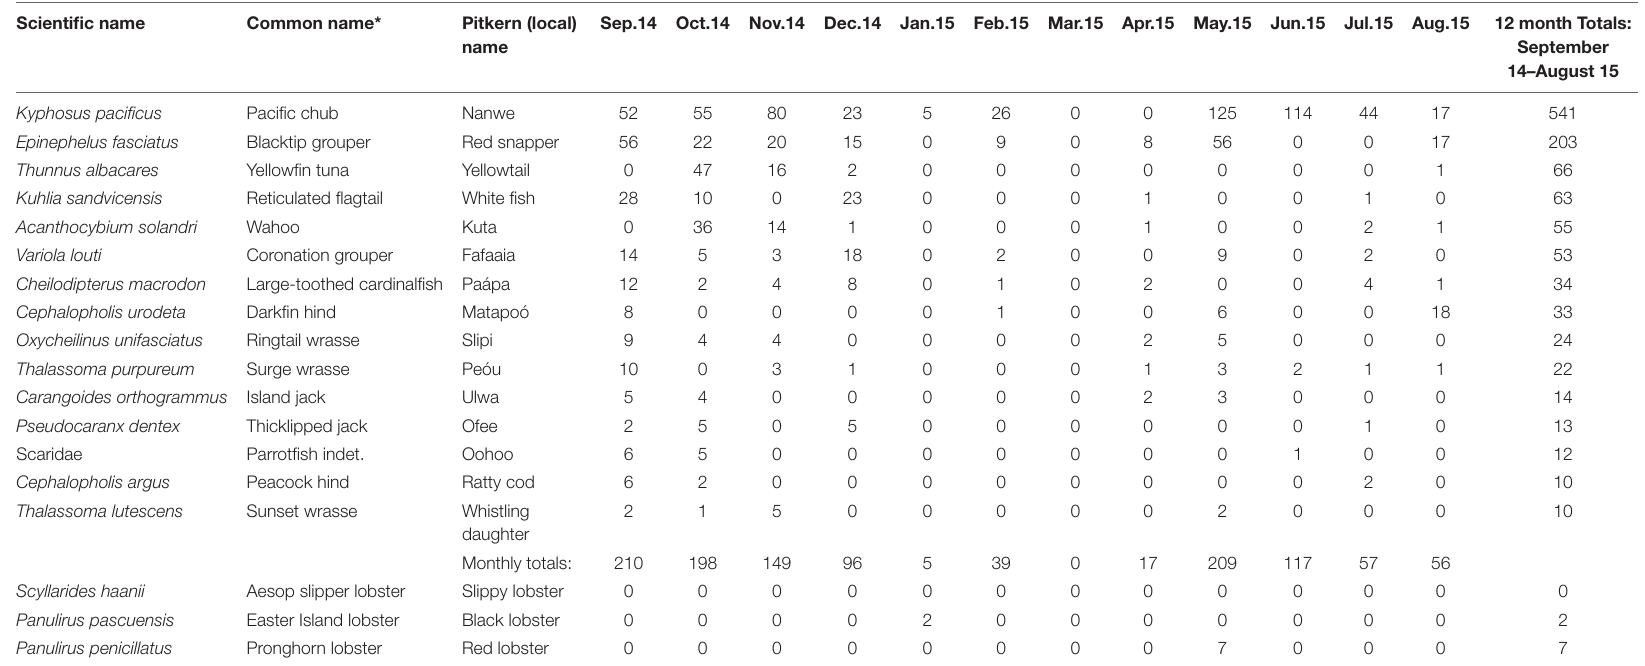
TABLE 2 | Pitcairn fish catch records (September 2014–August 2015) showing the 15 most frequently caught species ( ≥ 10 individuals) during the year, by